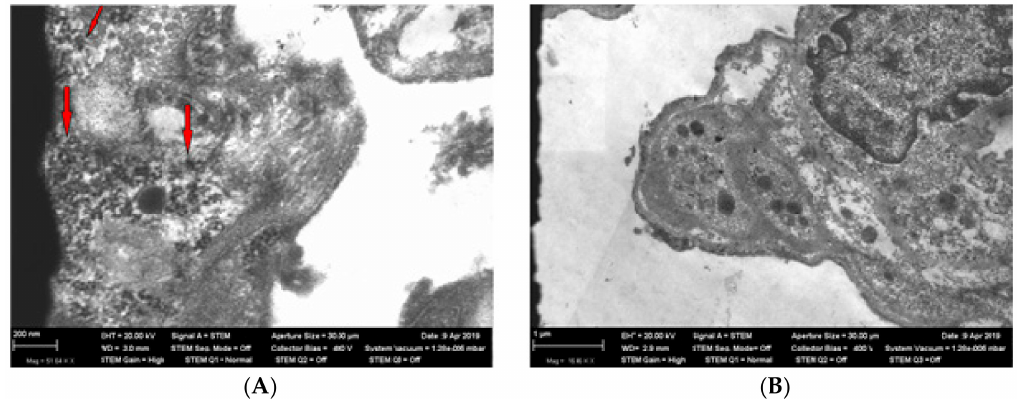
Figure 1. Panel ( A )—nanoparticles (shown by arrows) in alveolocytes of type 1 (TEM, magnification × 51,640) in rat lungs from the exposed group. Panel ( B )—alveolocytes of type 1 (TEM, magnification × 16,480) in rat lungs from the control (sham-exposed)